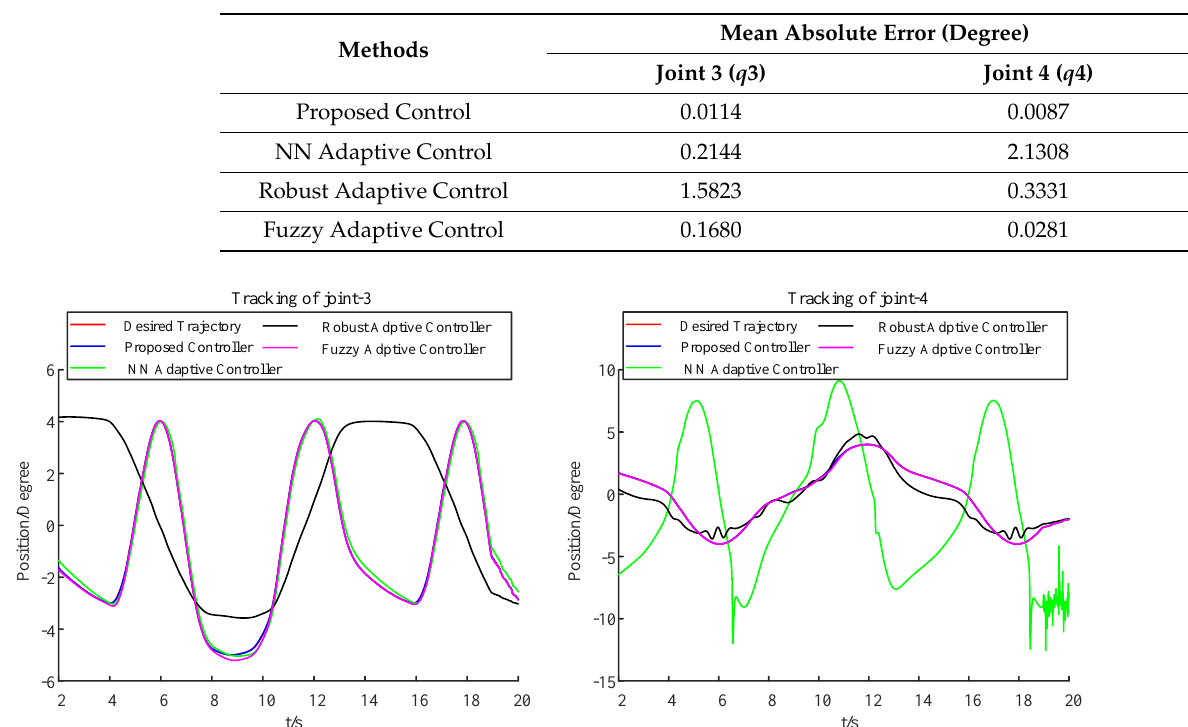
Figure 7. Trajectory tracking under different methods.